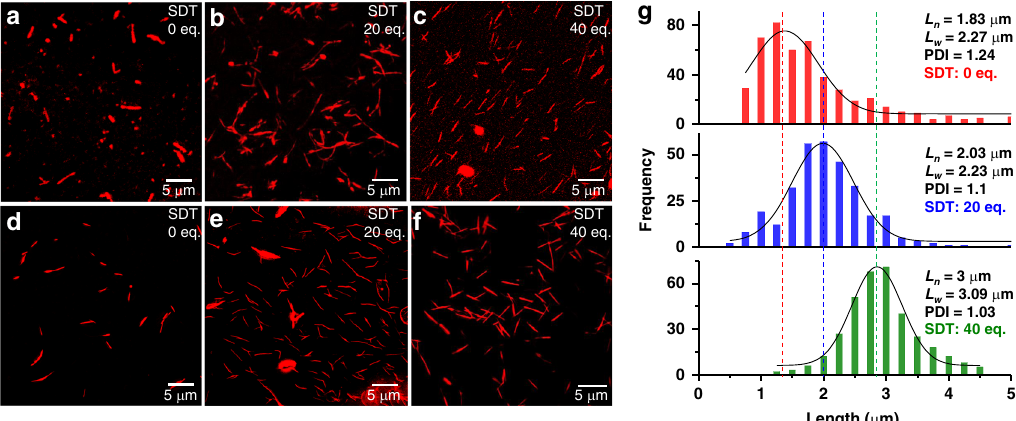
Fig. 6 Structural parameters of PNF supramolecular polymers. Confocal laser scanning microscopy (CLSM) images of a instantaneously prepared PNF assemblies with 0 eq. SDT, b kinetically grown tape structures using 20 eq. of SDT and c kinetically grown structures with 40 eq. SDT. d – f are corresponding structured illumination microscopic (SIM) images. g Histogram showing the length distribution of the tapes for instantaneously grown structures from top to bottom at 0 eq. SDT (PDI = 1.24, L w = 2.27 µ m, L n = 1.83 µ m, n = 473, red color histogram), kinetically controlled growth of tapes at 20 eq. SDT (PDI = 1.1, L w = 2.23 µ m, L n = 2.03 µ m, n = 472, blue color histogram) and at 40 eq. SDT (PDI = 1.03, L w = 3.09 µ m, L n = 3 µ m, n = 350, green color histogram), obtained from the SIM images. The dotted lines are drawn from the maximum for each eq. of PDI distribution to guide the eye. L w = weight-average length, L n = number-average length, n = number of tapes counted, PDI = polydispersity index. [PNF] = 5 × 10 − 5 M, CH 3 CN/H 2 O (1:1 v/v), pH = 8, buffer. Fluorescent probe: 5 µ M Nile red, λ exc = 561